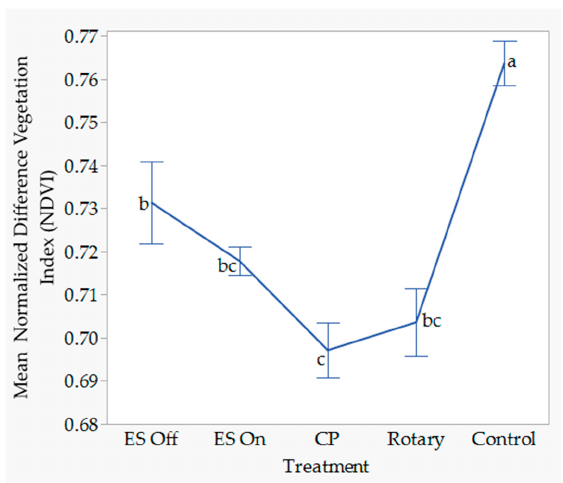
Figure 11. Mean NDVI (±SEM) obtained from aerial imagery taken at 16 DAT. Means with the same lowercase letters are not significantly different ( p < 0.0001) according to Tukey’s HSD test. The treatments described on the X -axis are electrostatically charged off (ES Off) and charged on (ES On) nozzles, the conventional hydraulic (CP) nozzle, and the rotary atomizer (Rotary) nozzle, compared with the Control.